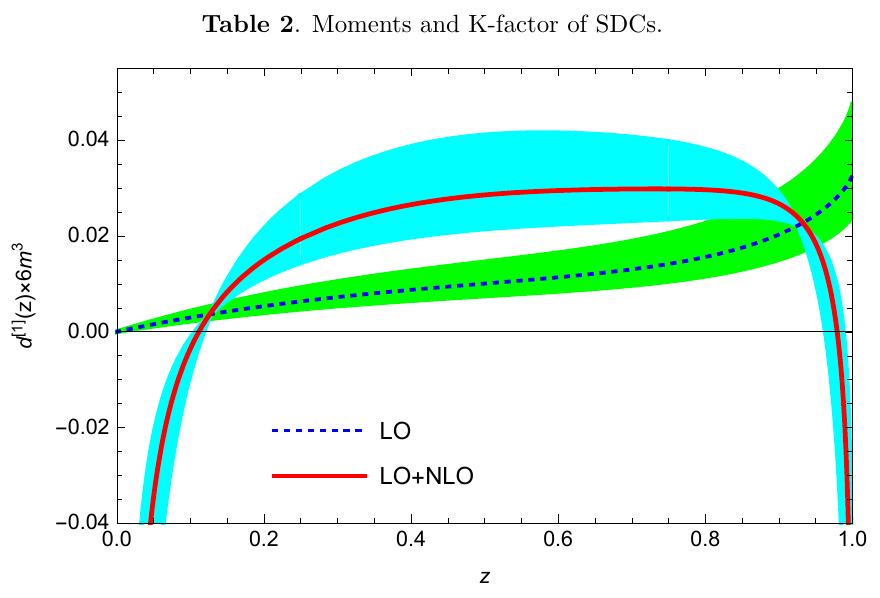
Figure 8 . SDCs of the fragmentation function of g ! b (cid:22) b ( 1 S [1] line is for d [1] ( z ) (cid:2) (6 m 3 ), while the solid line is for b LO (cid:22) r = (cid:22) f = 2 m b . The bands are obtained by varying the renormalization scale (cid:22) r by a factor of